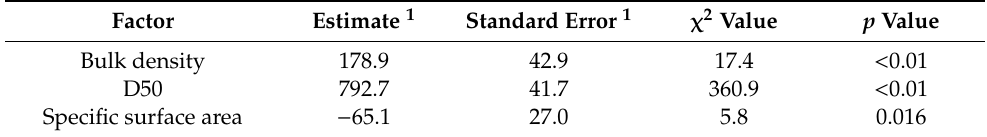
Table 3. Crucial powder properties a ff ecting % retention of friability estimated using the ENET technique. Factor